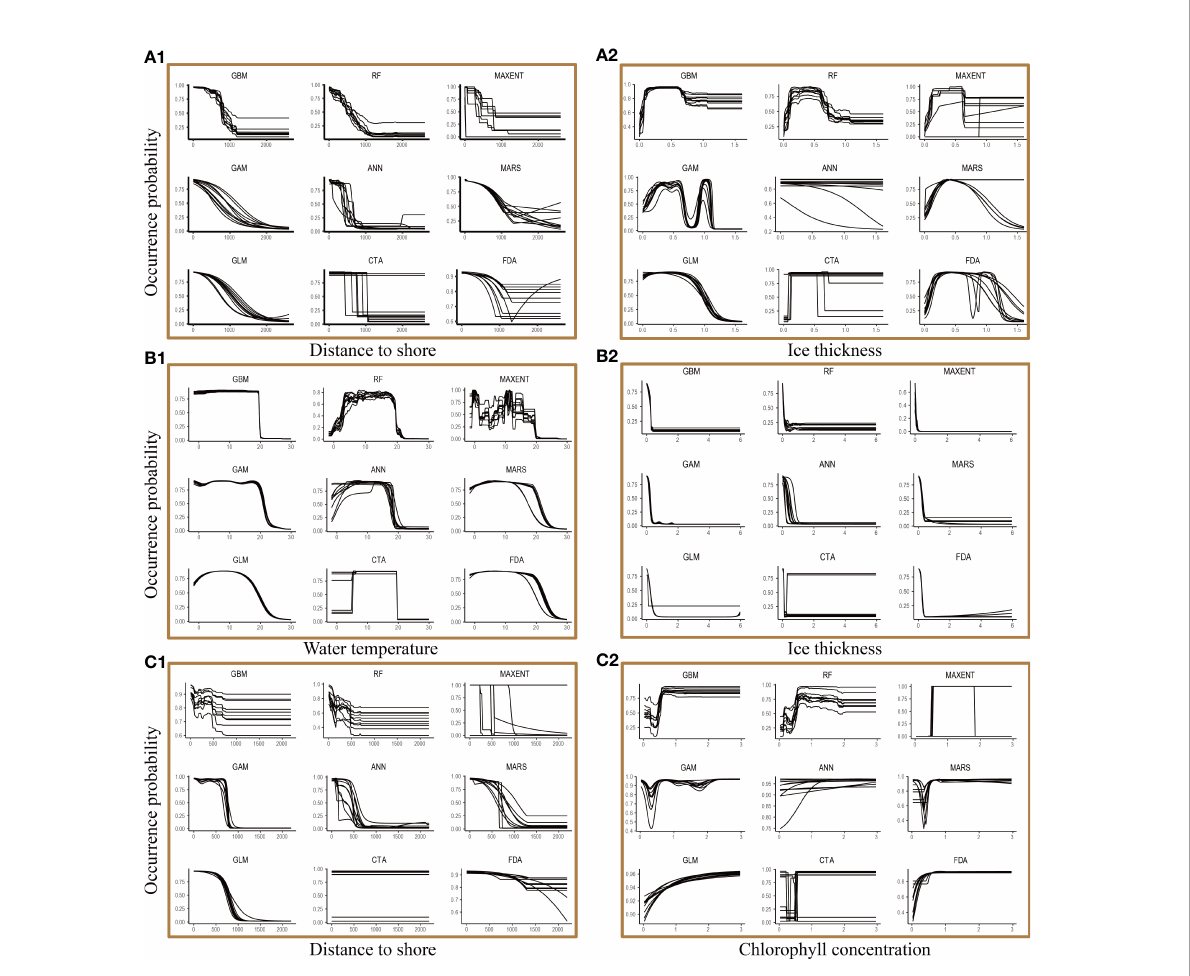
FIGURE 6 The response curves of population occurrence probability against the two most important driving factors for the Southern Hemisphere population (A1, A2) , the North Atlantic population (B1, B2) , and the North Paci fi c population (C1, C2) based on the population-level